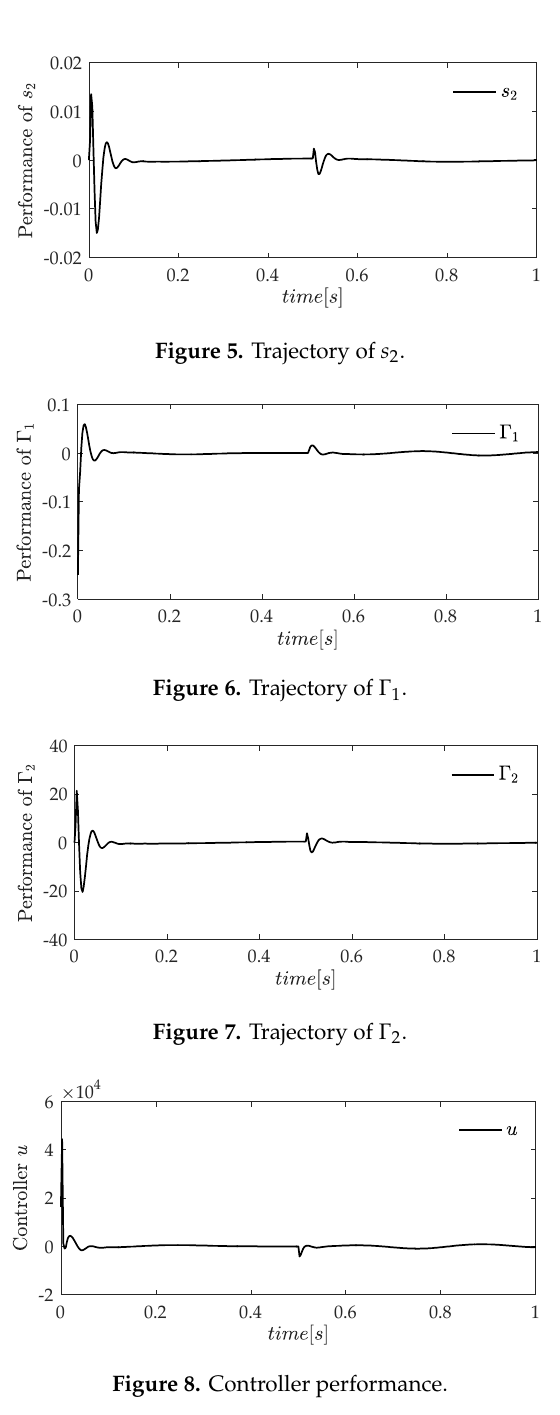
Figure 8. Controller performance.